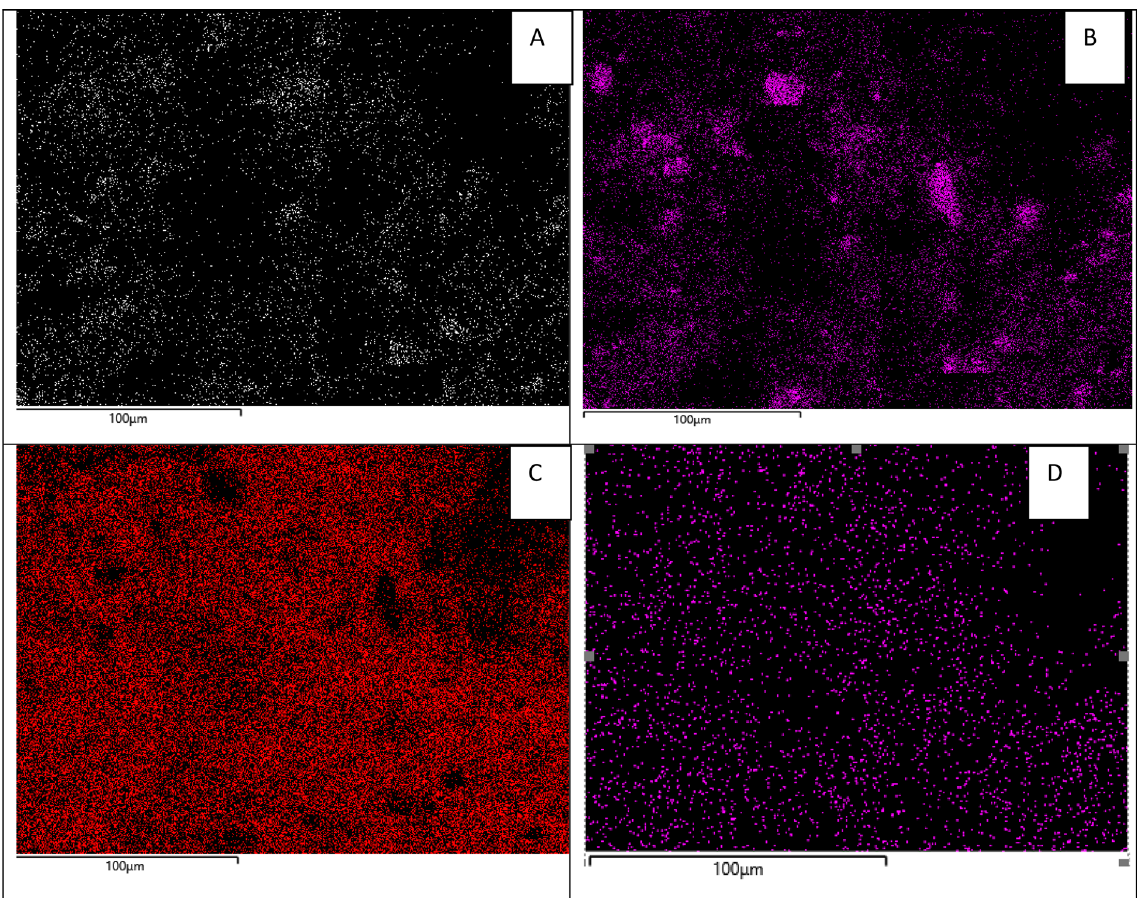
Figure 2. Electron micrographs of the filters with a pore size of 2400 nm surface after sample 3 filtration with elements maps (A) Al, (B) Si, (C) Fe, (D) U (SEM EDX